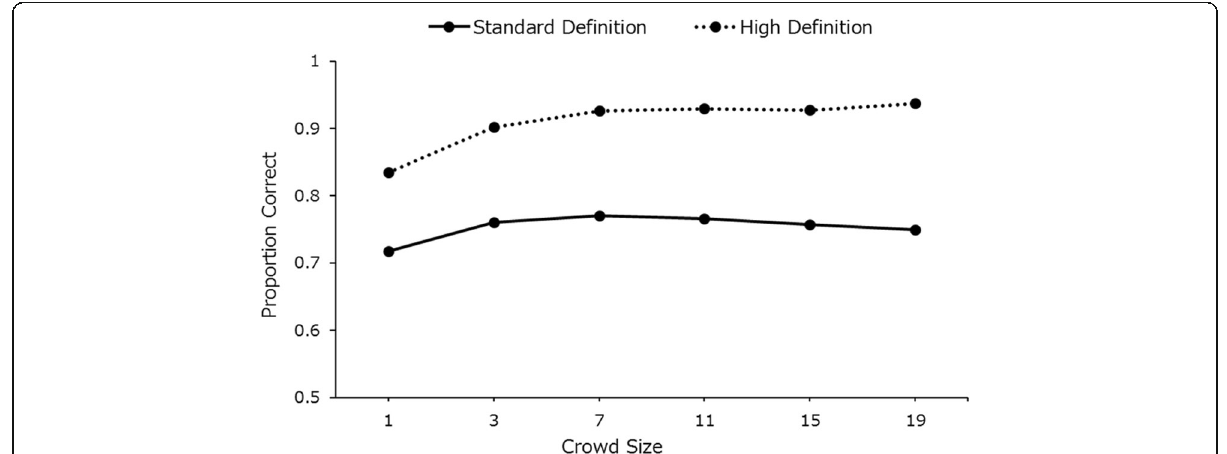
Fig. 10 Mean face-search accuracy for standard definition (SD) and high definition (HD) trials as a function of crowd size. As each point represents the average performance of 16,000 randomly sampled groups of participants (1000 groups per target identity), standard error bars (mean standard error = 0.003 for SD trials and mean standard error = 0.002 for HD trials) would lie within the marker point and are therefore not represented on the